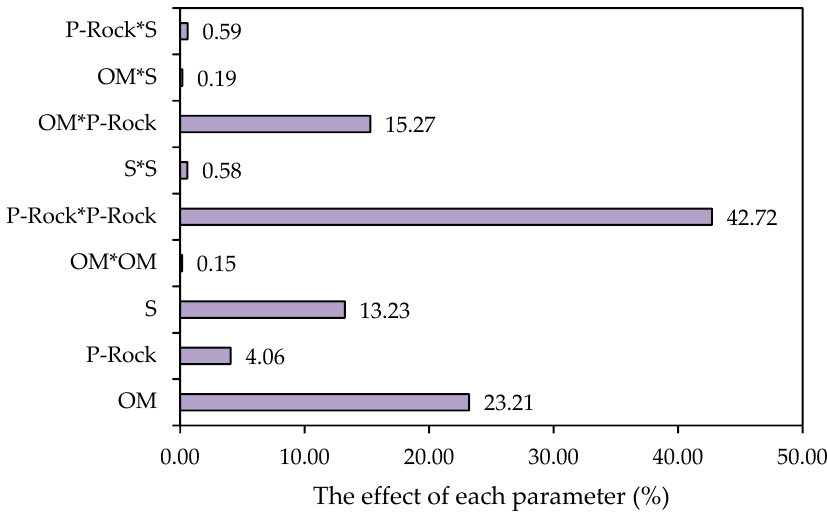
Figure 3. The results of the Pareto comparison of the effects of the input parameters of the central composite design model on P solubilization. P ‐ Rock, phosphate rock; OM, organic matter; S, sulfur.